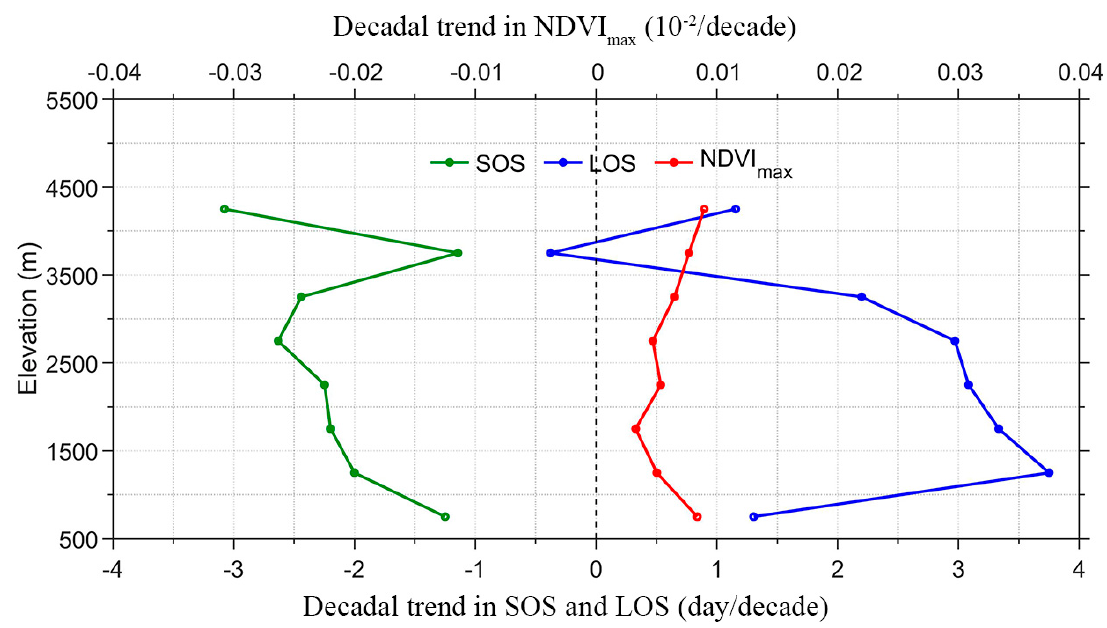
Figure 3. Elevation distribution of trend in land surface phenology (SOS, LOS, and NDVI max ) in the Tianshan Mountains from 1983 to 2015.